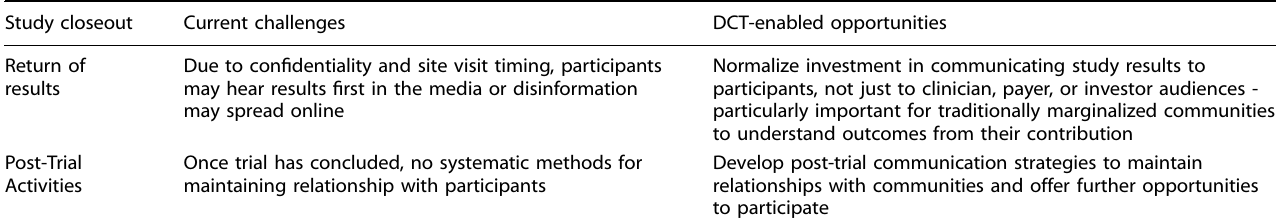
Table 2. Opportunities for DCT to enhance inclusivity in the closeout phases of a